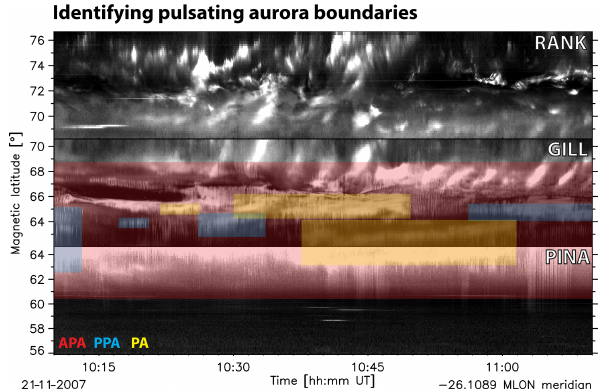
Figure 2. An example of a keogram used to approximately define pulsating aurora occurrence. The regions where amorphous pulsat- ing auroras (APAs, red), patchy pulsating auroras (PPAs, blue), and patchy auroras (PAs, yellow) can be identified in the keogram are marked with rectangles. The meridian that the keograms are aligned along is illustrated in Fig. 1.